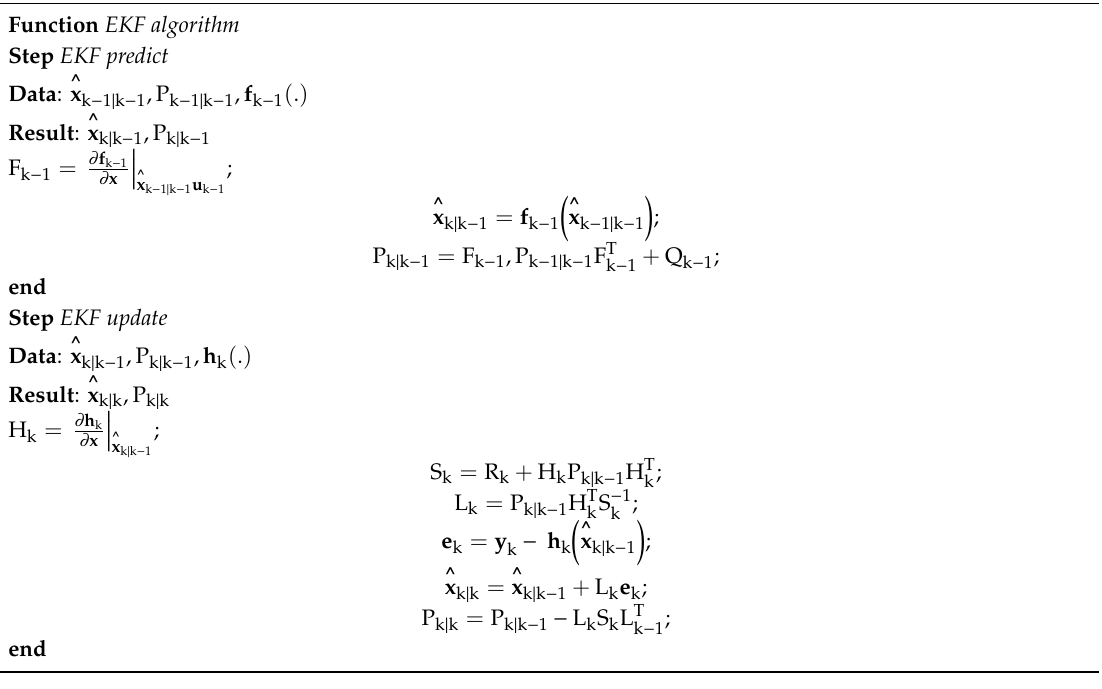
Algorithm 1. Navigation filter based on the extended Kalman filter (EKF). Function EKF algorithm